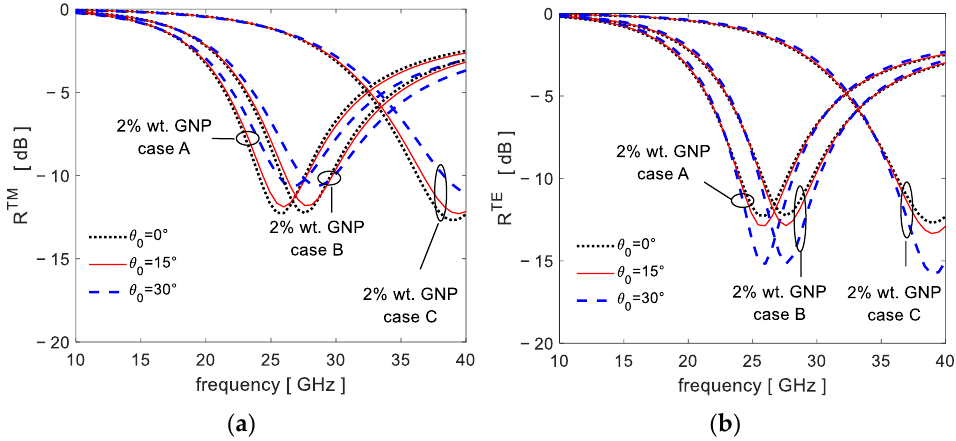
Figure 11. Reflection coefficients ( a ) R TM and ( b ) R TE as functions of the incidence angle for the cases